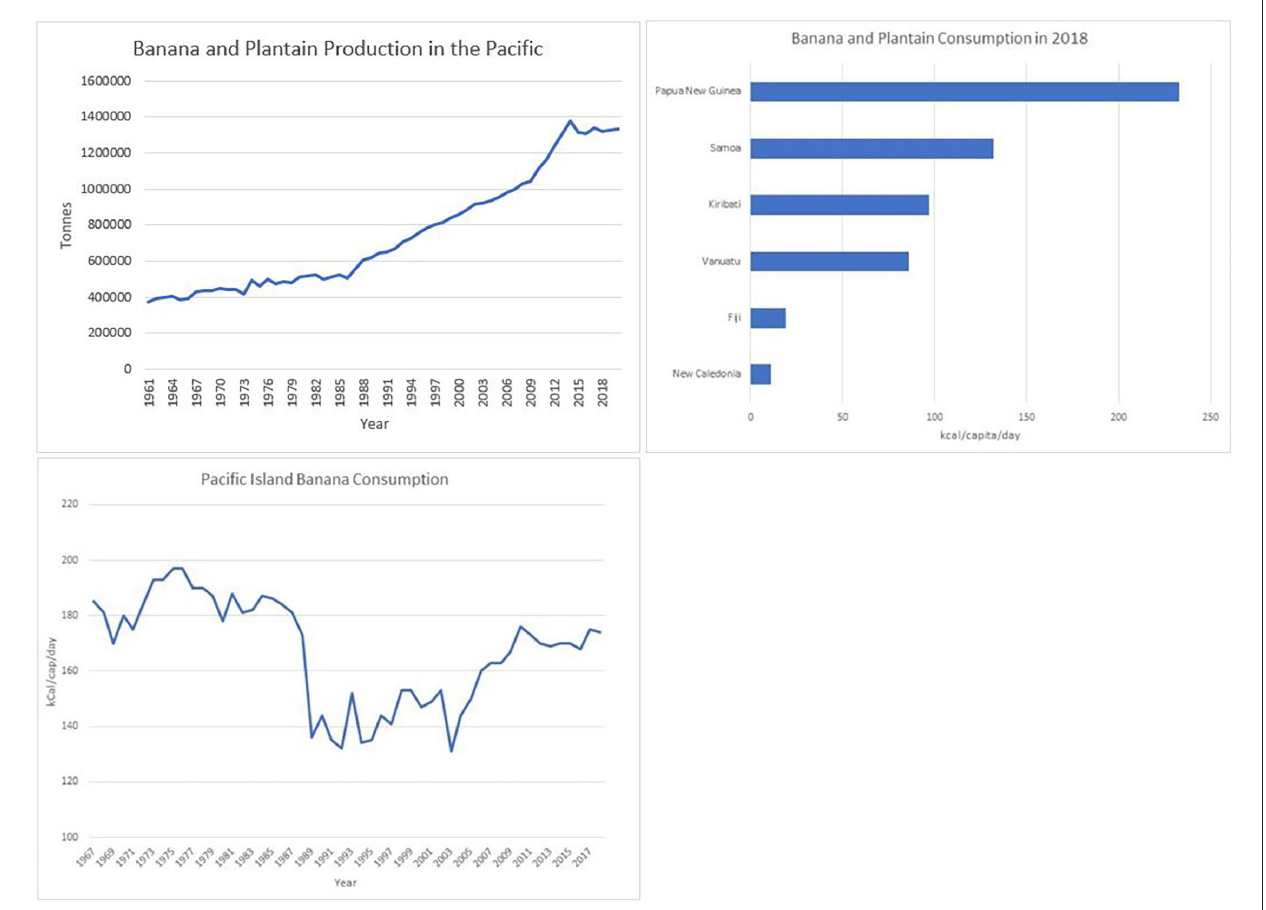
FIGURE 1 | Banana production and consumption in the P.I region. Source: FAOSTAT Food Balance Sheets—calculated by